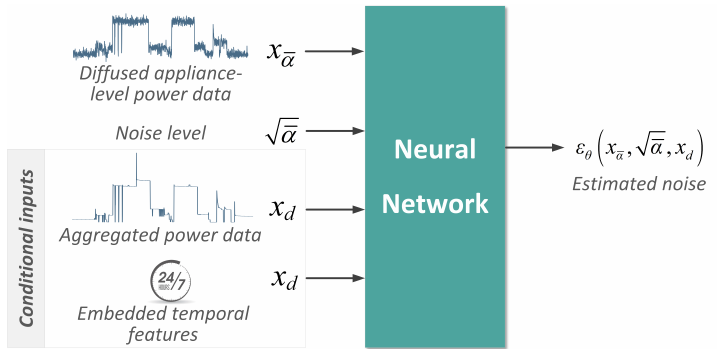
Figure 4. Conditional diffusion model for NILM task. The neural network takes diffused data x ¯ α , √ ¯ α and conditional data x aggre and x times as inputs to estimate the corresponding noise ε θ noise level